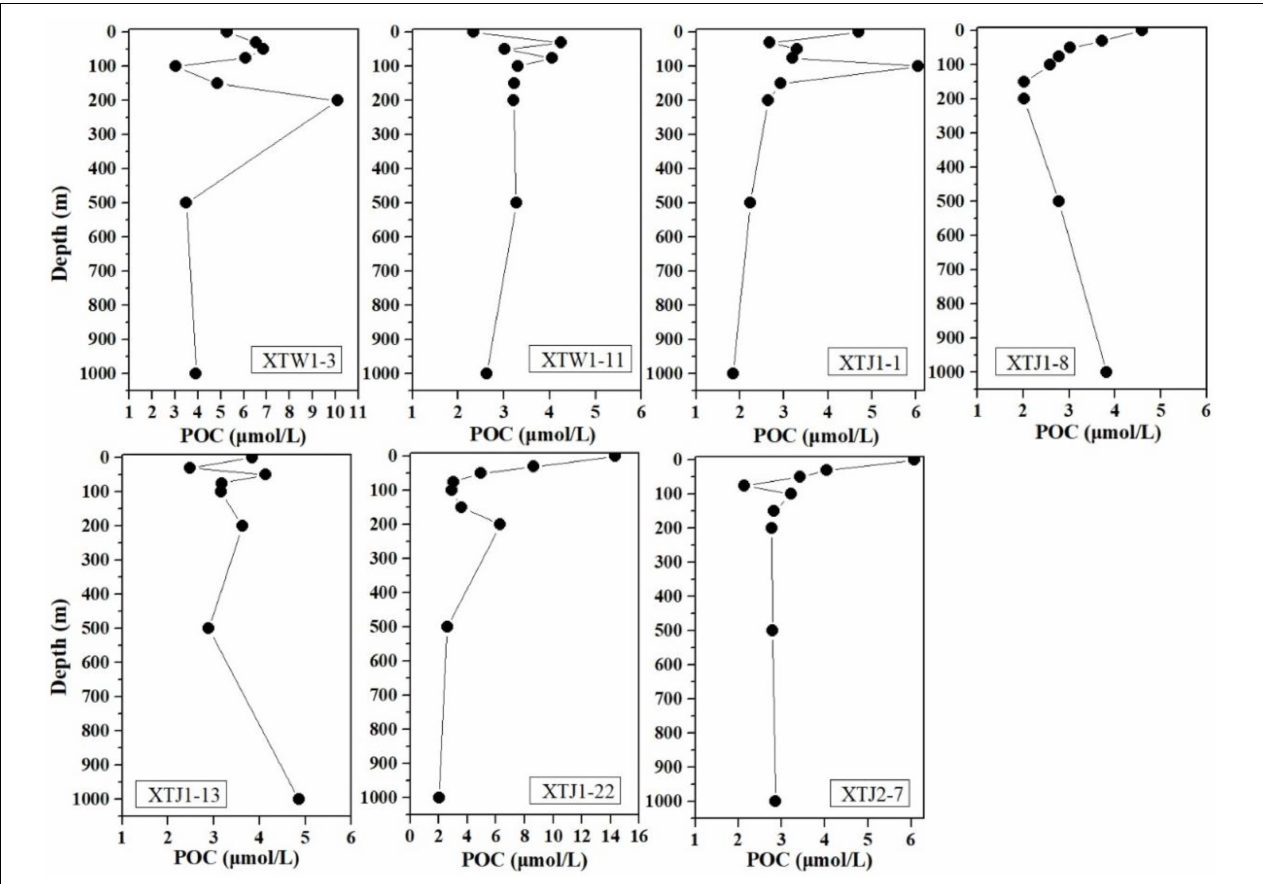
FIGURE 3 | Vertical profiles of the POC concentration at 7 stations in the w-NPO during May-June 2018.